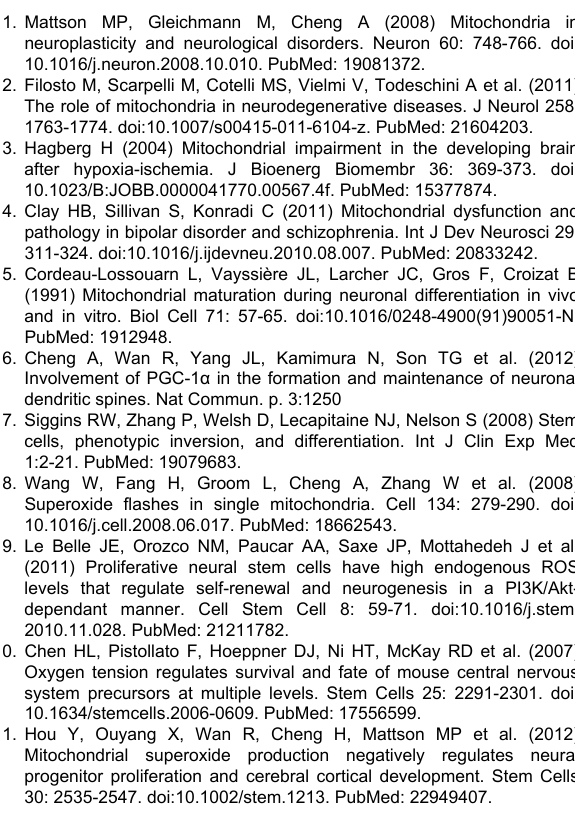
Figure S1. Percentage of SOX2, Tuj1 and GFAP positively stained cells at different days of differentiation (days 0 to 4). NPCs, neurons and astrocytes were identified by antibodies against SOX2, Tuj1 and GFAP, respectively. Total numbers of cells were determined by counting DAPI-stained nuclei. n = 4 separate experiments performed on NPCs cultured from 4 pregnant mice. *p<0.05 compared to the percentage of cells stained with SOX2 at day 0. #p<0.05 compared to the percentage of cells stained with Tuj1 at day 1. (PDF) Movie S1. Example of superoxide flashes occurring in groups of mitochondria in newly-generated